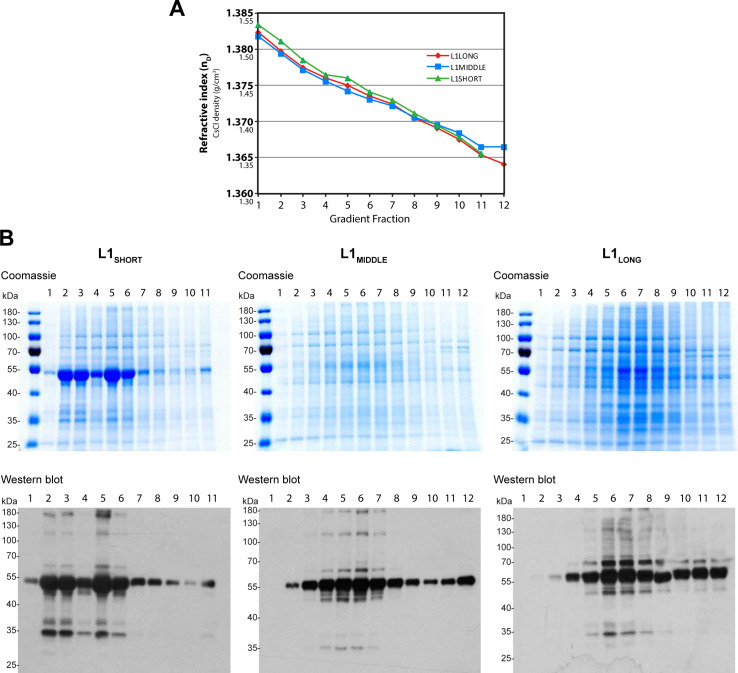
Production of L1 isoforms with the MultiBac baculovirus expression system.(A) The CsCl density (refractive index) of each fraction was determined via refractometer at RT. (B) Analysis of fractions from PsV production with L1SHORT, L1MIDDLE and L1LONG analyzed by Coomassie blue staining (upper panels) and Western blot (lower panels). Immunoblots were incubated with a serum mix from five MnPV-infected tumor-bearing animals.